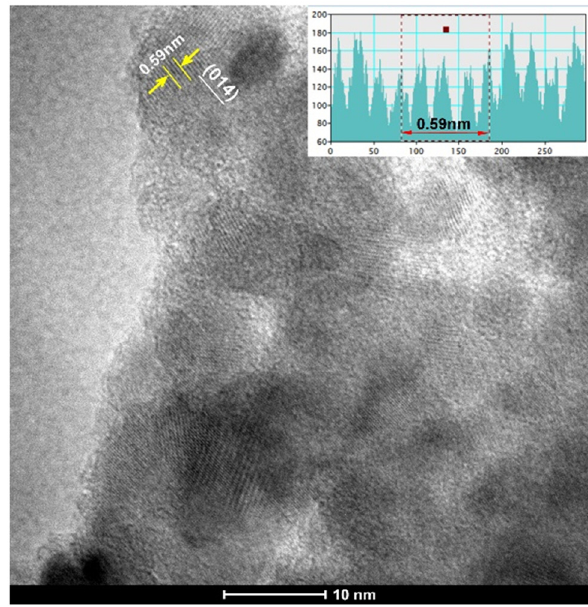
Figure 6: Results from TEM analysis of copper oxide scale after oxidation in an ethanol combustion